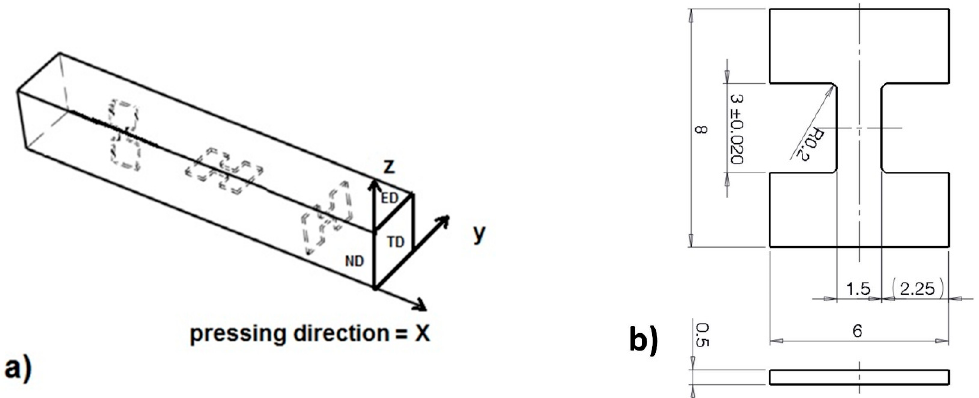
Figure 2. ( a ) The sample coordinate system and the orientation of the specimens. ( b ) Dimensions of the specimens used for micro-tensile tests.